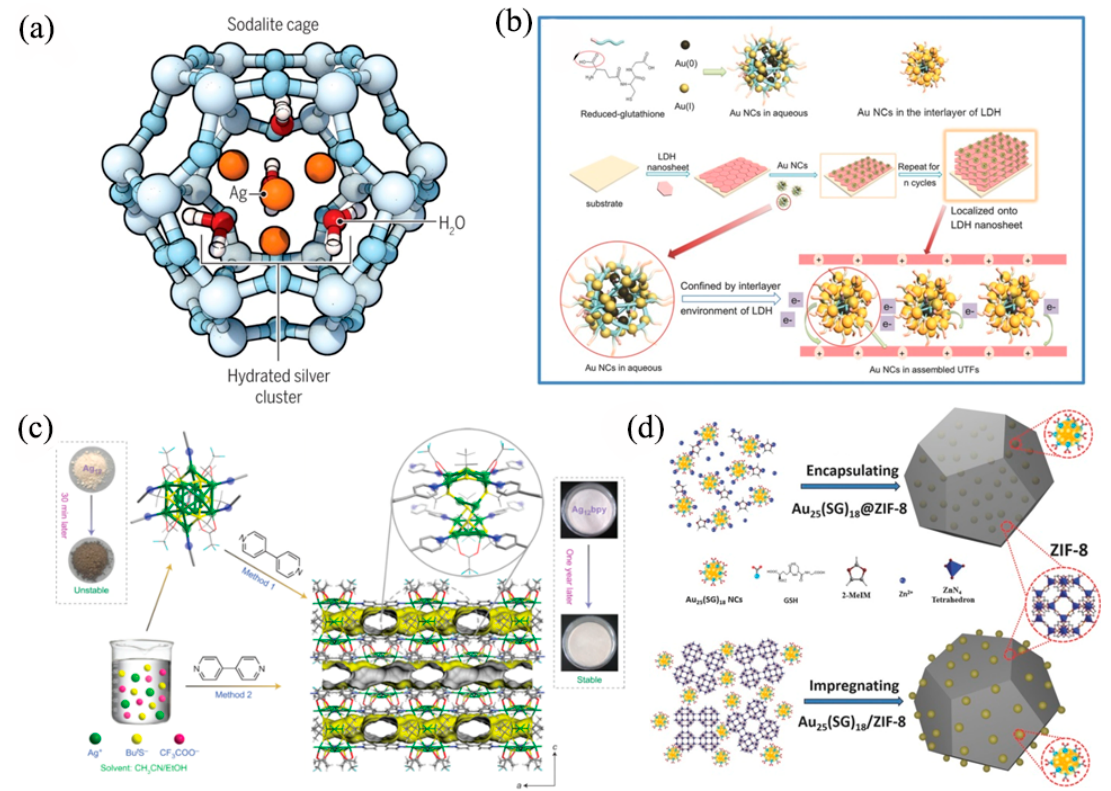
Figure 6. ( a ) Diagram of a hydrated Ag 4 NC-contained sodalite zeolite cage. Reprinted/adapted with permission from Ref. [50]. 2018, copyright American Association for the Advancement of Science. ( b ) Schematic representation of AuNCs’ luminescence enhancement. Reprinted/adapted with permission from Ref. [53]. 2015, copyright Wiley-VCH. ( c ) Mechanism model of the preparation of Ag 12 bpy NC-based metal-organic framework. Reprinted/adapted with permission from Ref. [57]. 2017, copyright Springer Nature. ( d ) Mechanism model of the synthesis processes for Au 25 (SG) 18 @ZIF-8 and Au 25 (SG) 18 /ZIF-8 nanocomposites. Reprinted/adapted with permission from Ref. [60]. 2017, copyright Wiley-VCH.